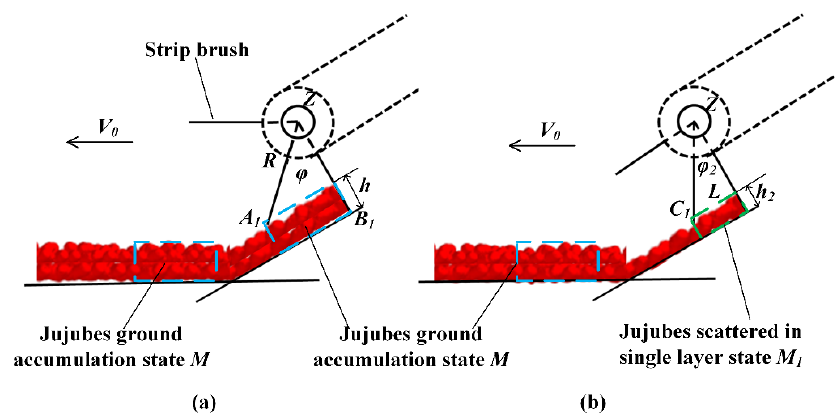
Figure 5. Jujubes climbing state hypothesis. ( a ) Jujubes climb along the comb teeth in the state of stacking on the ground, ( b ) Jujubes climb along comb teeth in a single layer state.